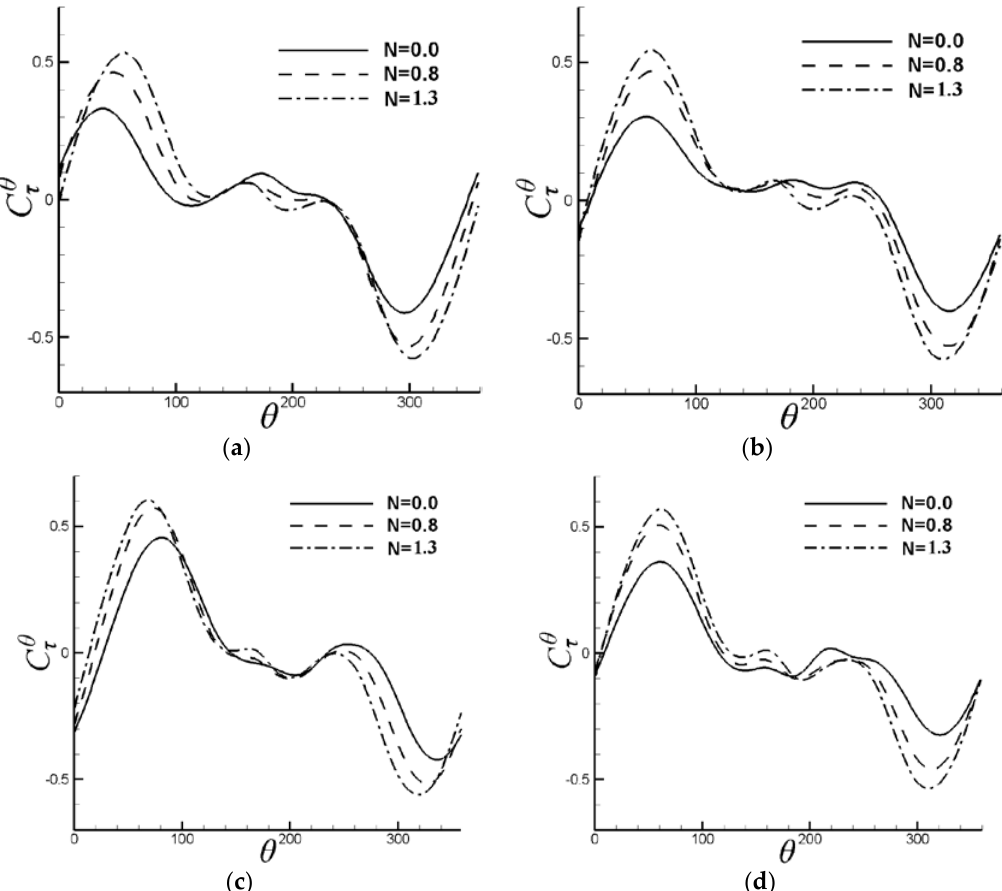
θ C on the surface of cylinder with different values of τ